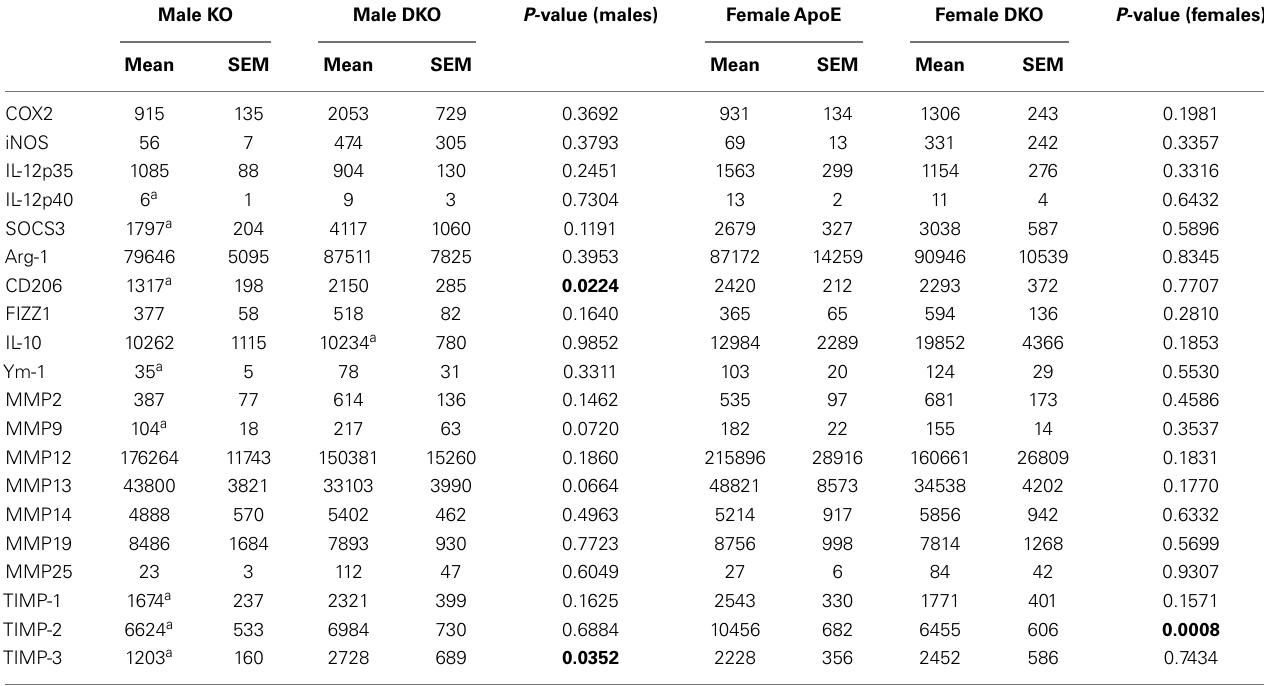
Table 5 | Characteristics of foam cell macrophages obtained from subcutaneous sponges